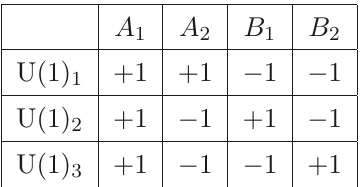
Table 6 . Assignments of U(1) 3 flavor charges in the τ f also has a simple relation to F